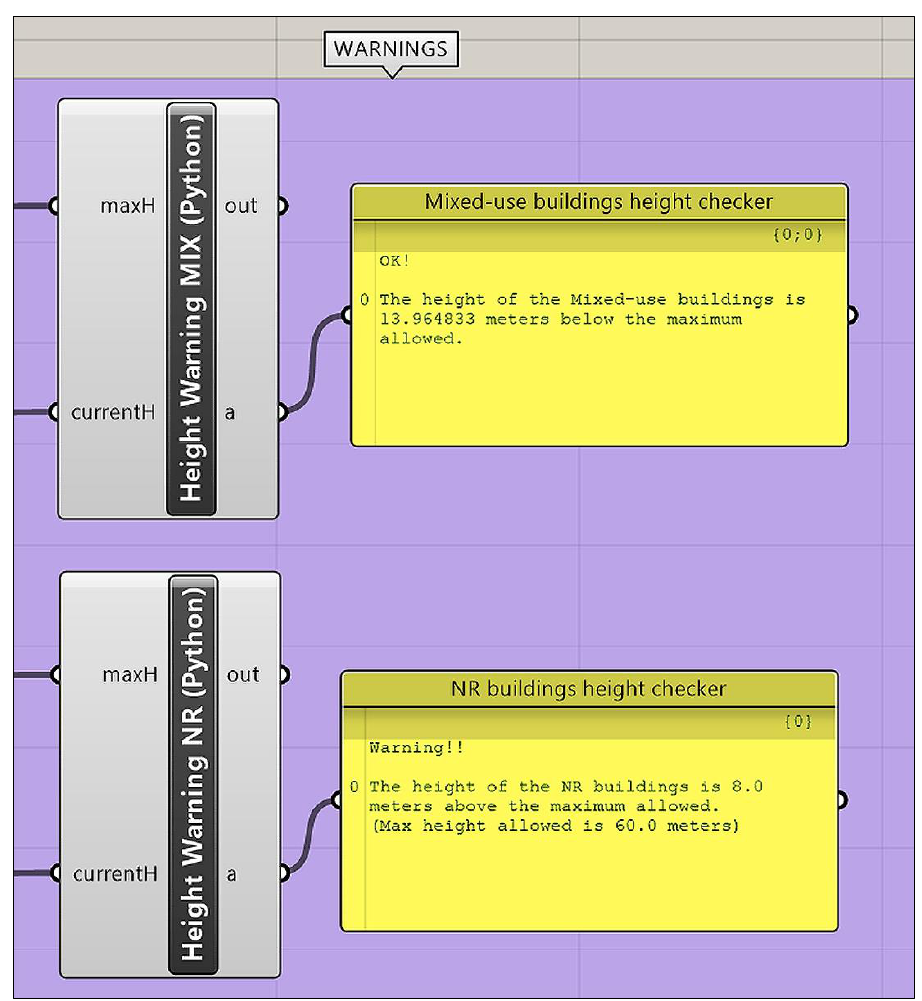
Figure 22. Example of warning issued by the tool to inform the user that the building height is exceeding the limit allowed.